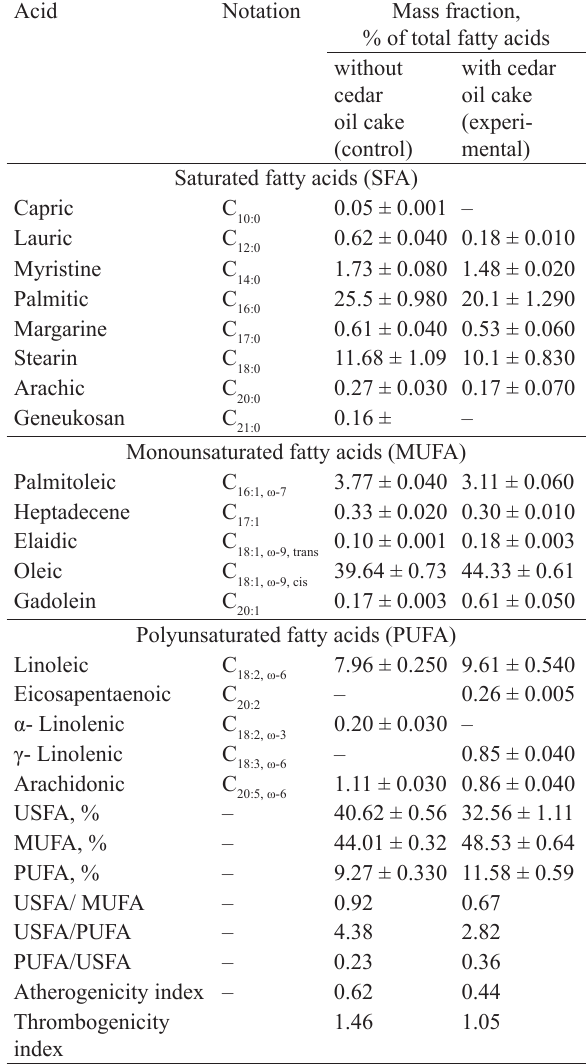
Table 2 Fatty acid composition of semi-smoked